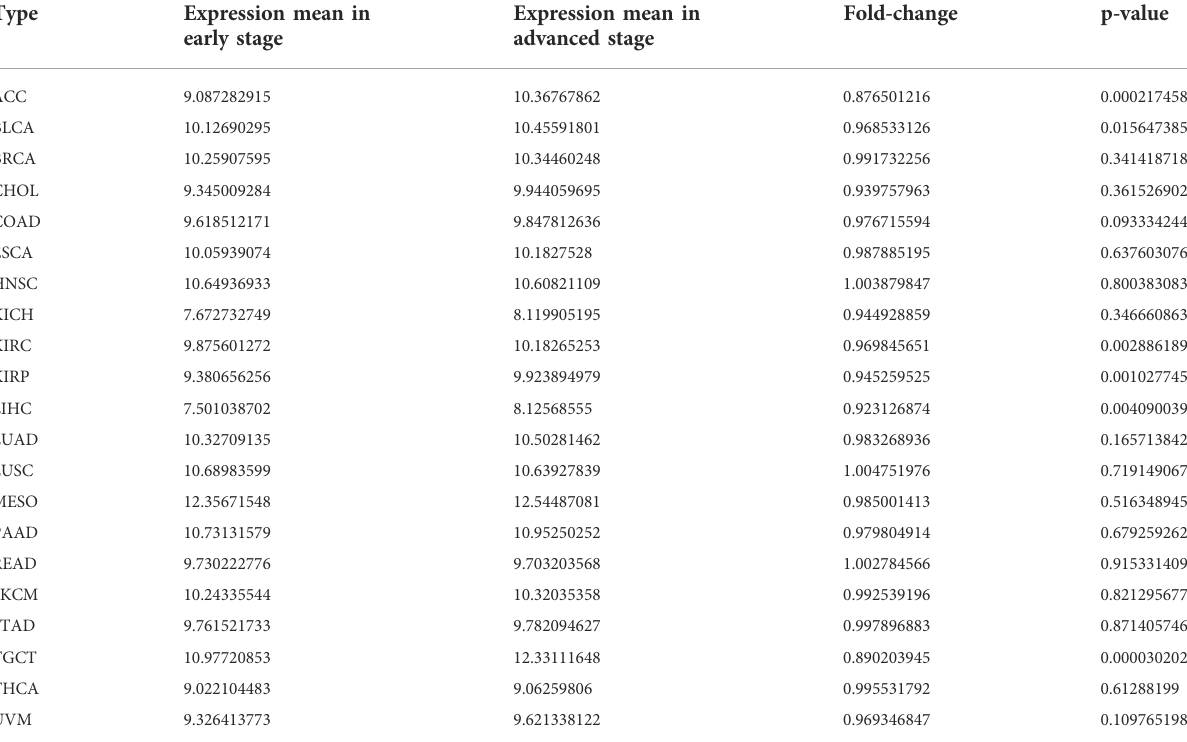
TABLE 1 Mean expression and fold-change of SERPINH1 in different early and advanced